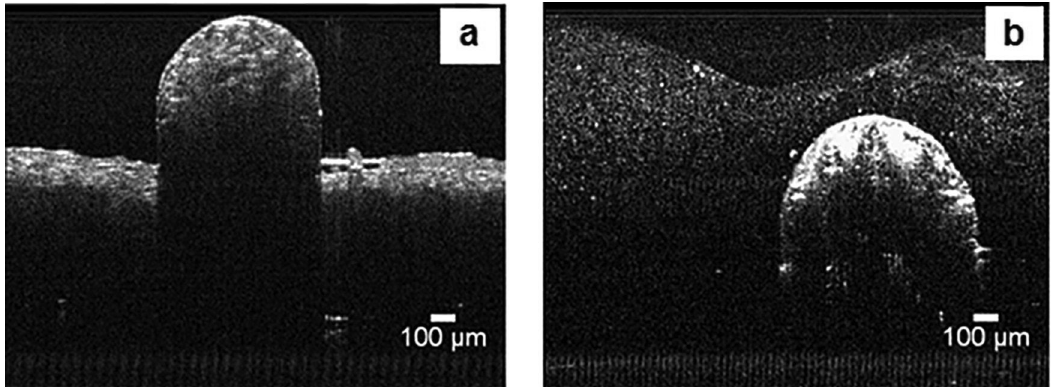
FIGURE 2 - Microspheres and carbomer gel 1.0% (w/w), (a) sphere above the carbomer gel and (b) sphere within the carbomer gel.